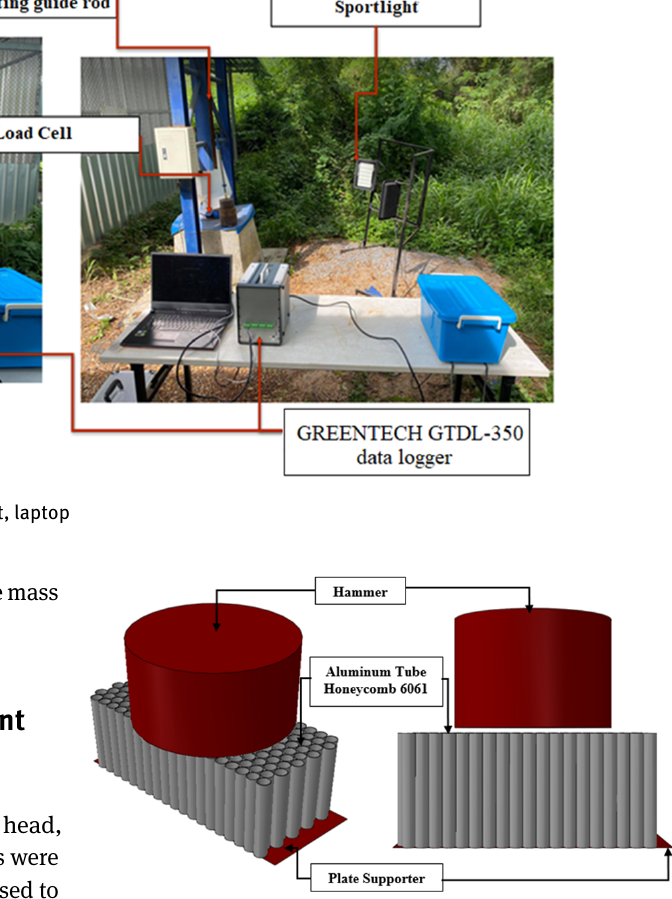
Figure 3: Characteristics of model analysis of aluminum honeycomb sheet in ABAQUS.CAE